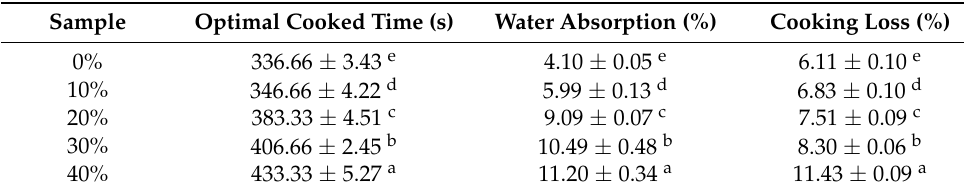
Table 6. Cooking properties of ginkgo biloba